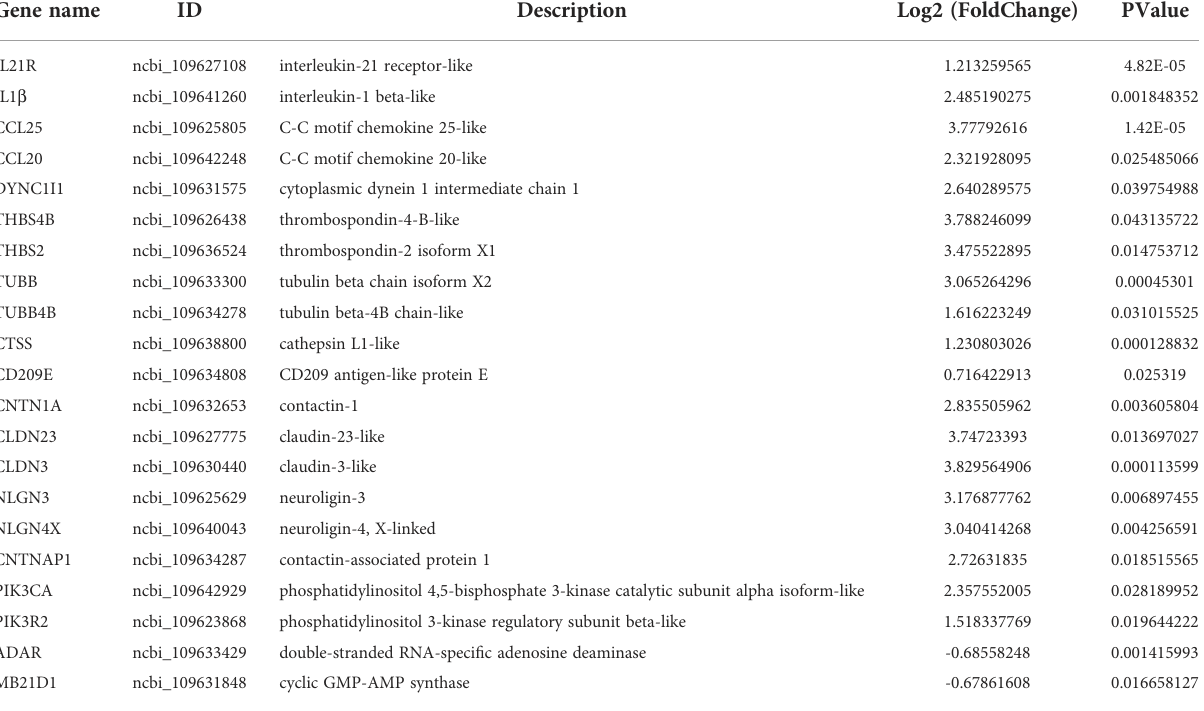
TABLE 3 Summary of immune-related genes in the inactivated vaccine group compared to the PBS group at 7 th day post